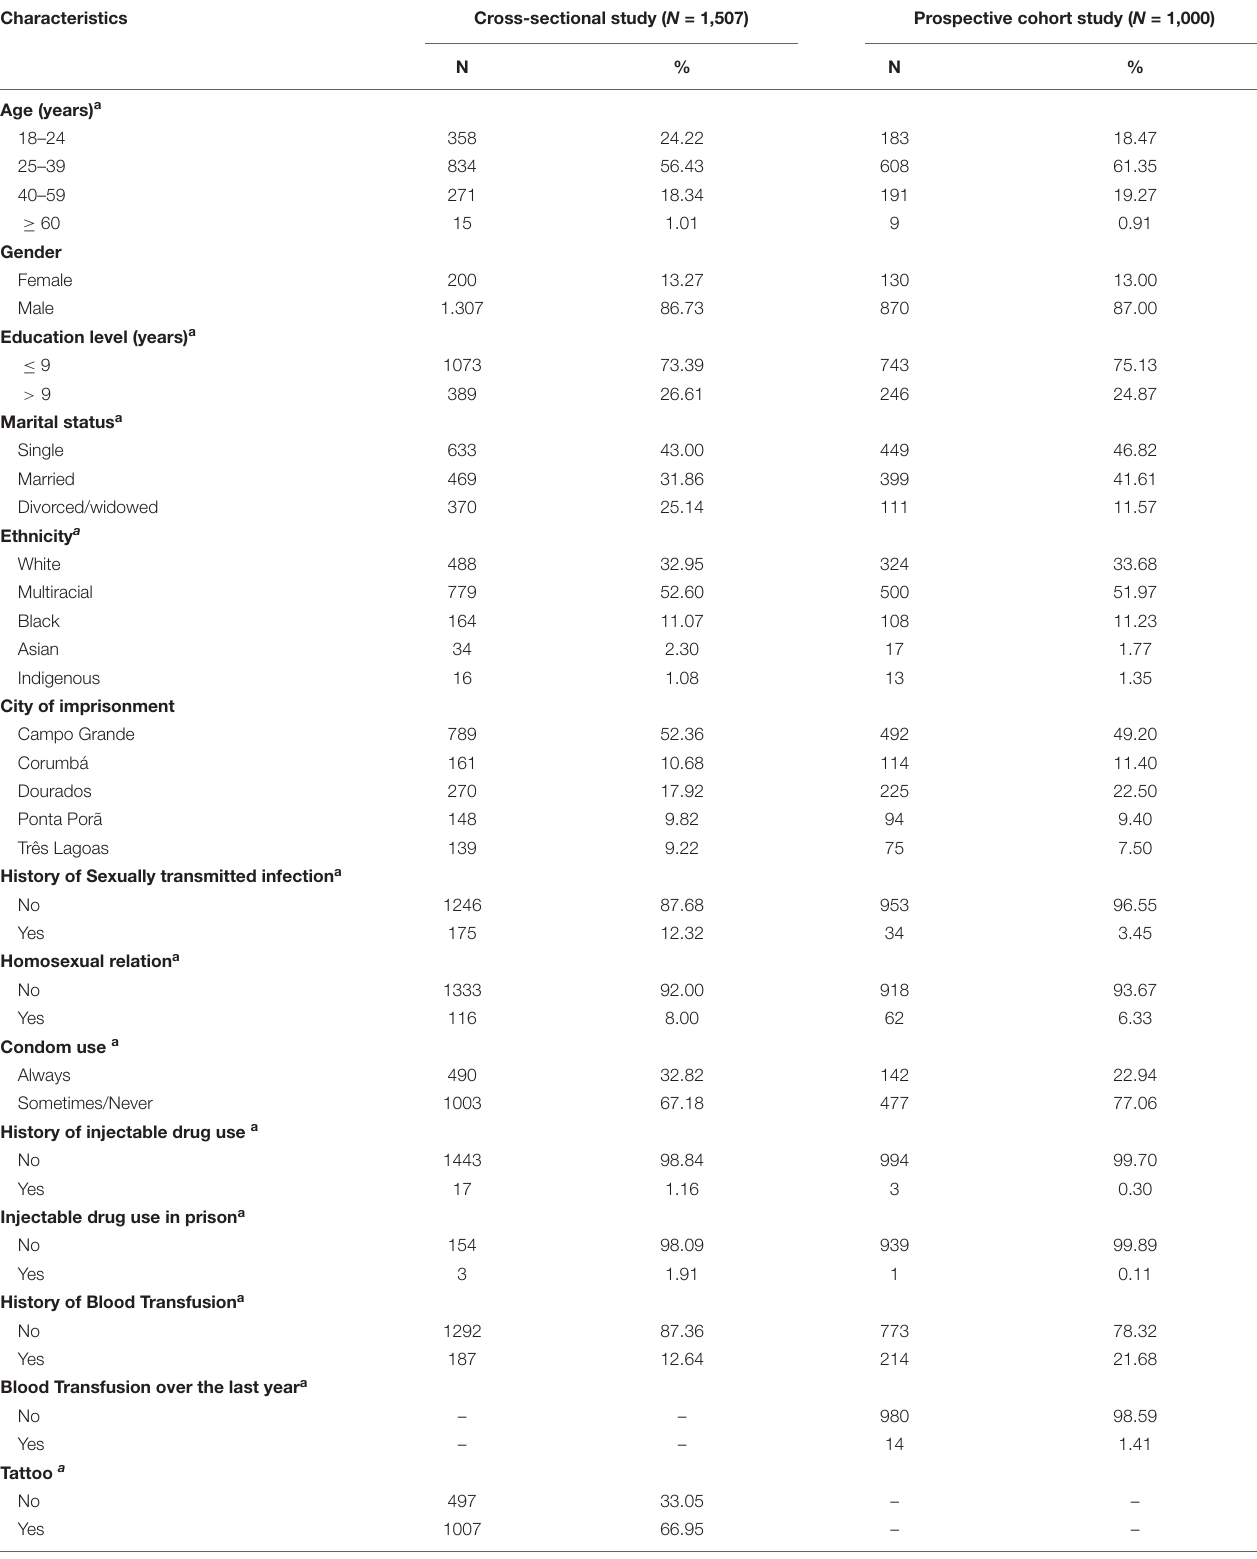
TABLE 1 | Characteristics of 1,507 inmates of the cross-sectional study and of 1,000 inmates of the cohort study.